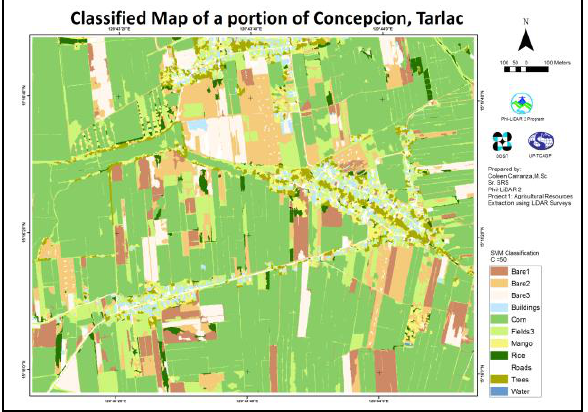
Figure 5. Agricultural land cover map produced using OBIA and SVM on LiDAR data and orthoimage.